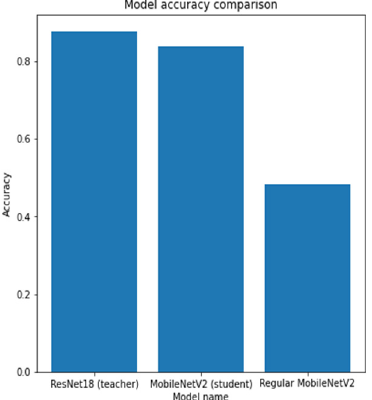
Figure 17. The comparison of the accuracy of the teacher model (the base ResNet18 model), the student model (MobileNetV2), and the regularly trained student model (MobileNetV2).